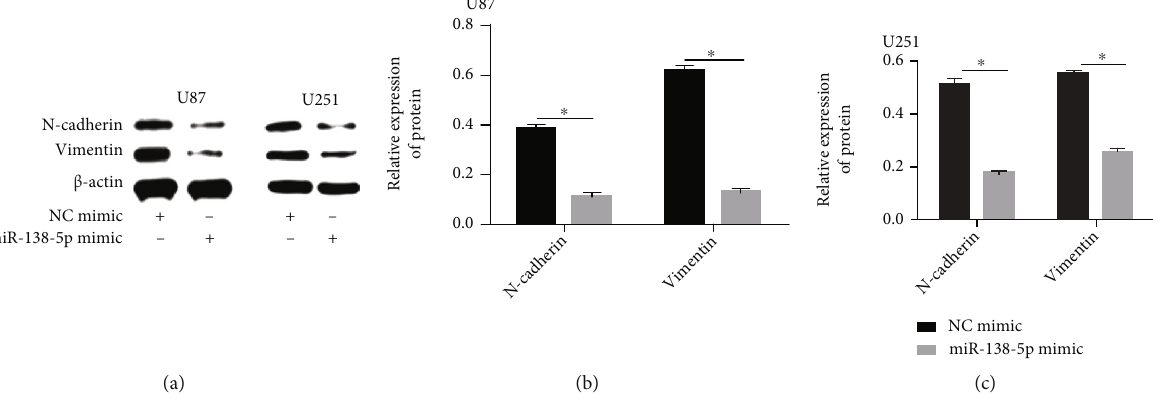
Figure 4: Protein levels of vimentin and N-cadherin. (a – c) Western blotting was used to detect protein levels of vimentin and N-cadherin 6h after transfection. Each experiment was repeated at least three times. ∗ P < 0 : 05